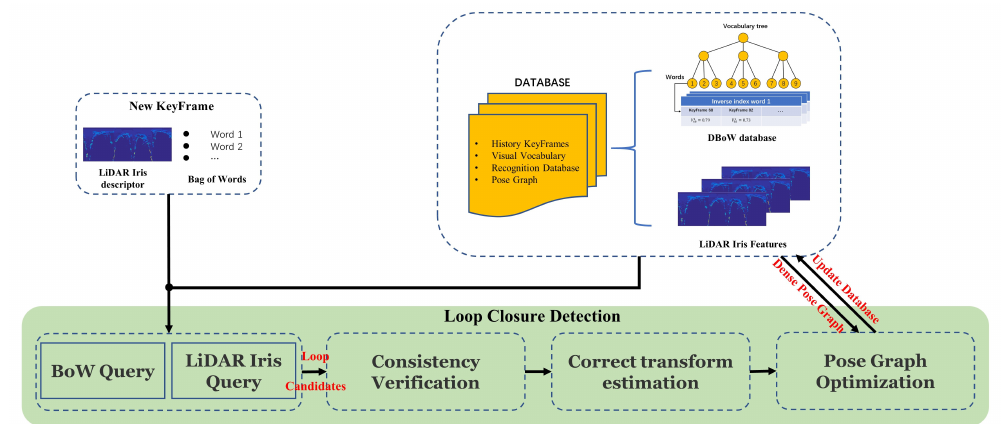
Figure 9. The proposed PGLS-Loop Closure Detection flowchart.